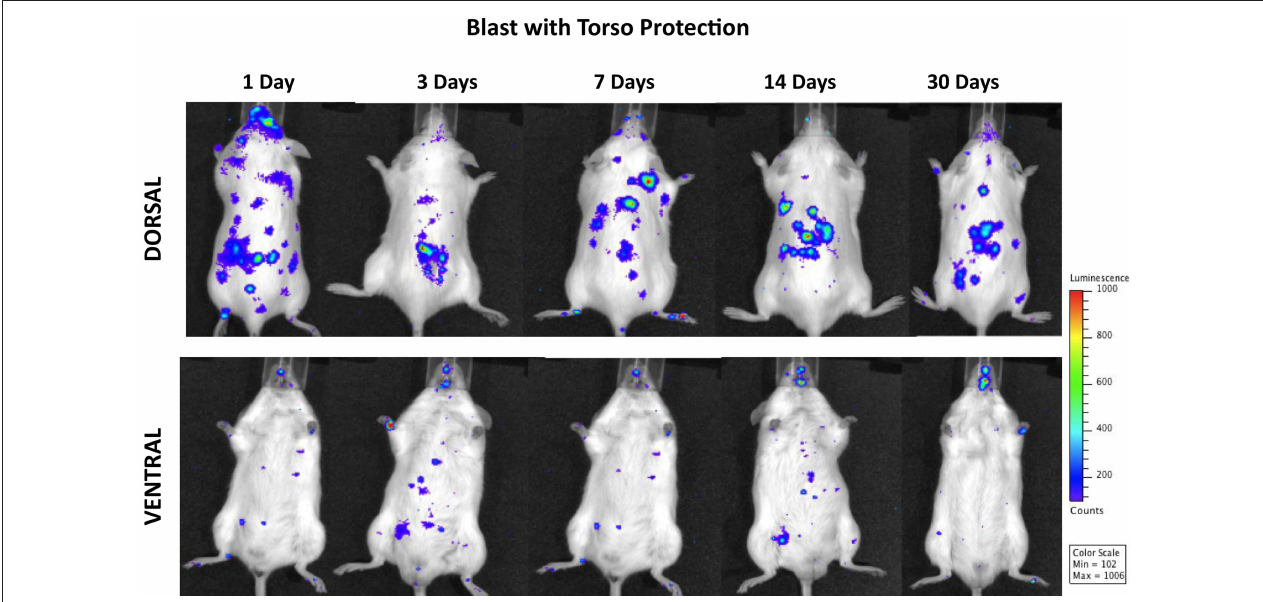
Figure 5 | Distribution of increased bioluminescence showing MPO activity in mice subjected to blast with torso protection while the head exposed, imaged during the 1-month observation period. The representative photographs show the same animal imaged in both dorsal and ventral positions